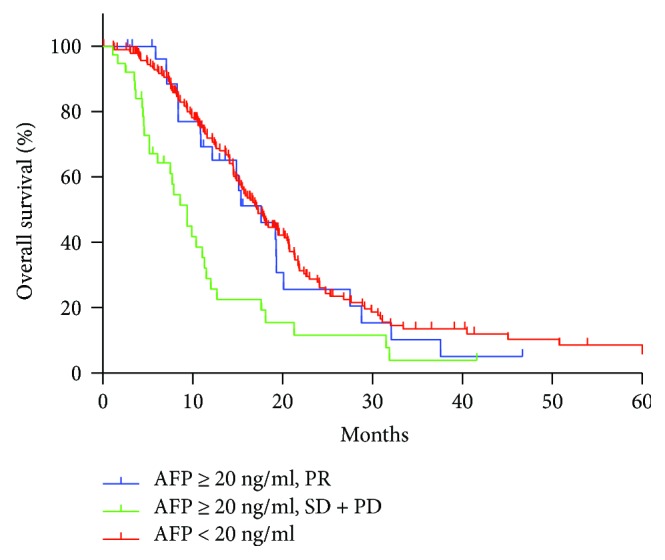
The median OS of group 1 (AFP ≥ 20 ng/ml and reached PR after first-line chemotherapy), group 2 (AFP ≥ 20 ng/ml and achieved SD/PD after first-line chemotherapy), group 3 (AFP < 20 ng/ml) was 17.6 m, 9.4 m, 17.3 m, respectively (P < 0.001).